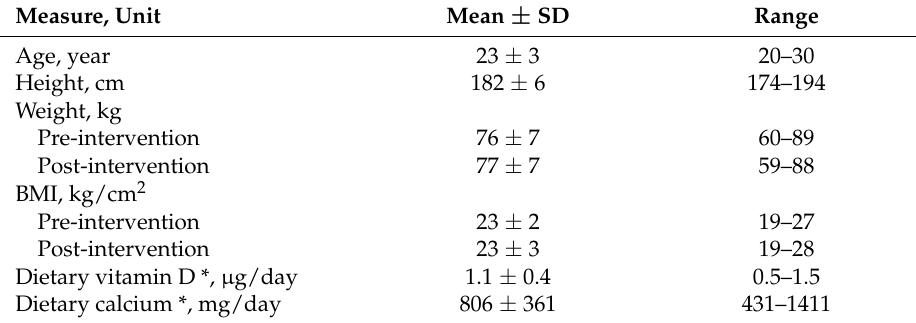
Table 1. Selected characteristics of the 12 male subjects, pre- and